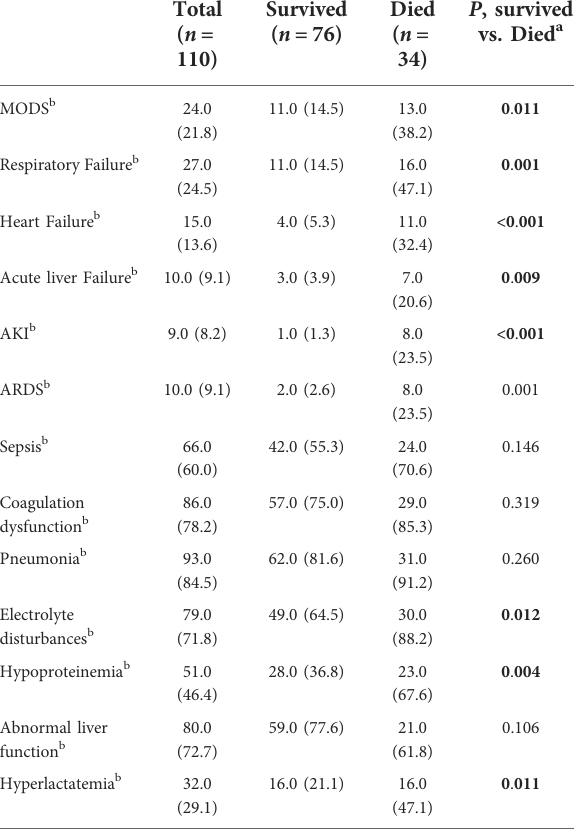
TABLE 2 Statistics of complications in 110 patients with HLH according to survival groups.